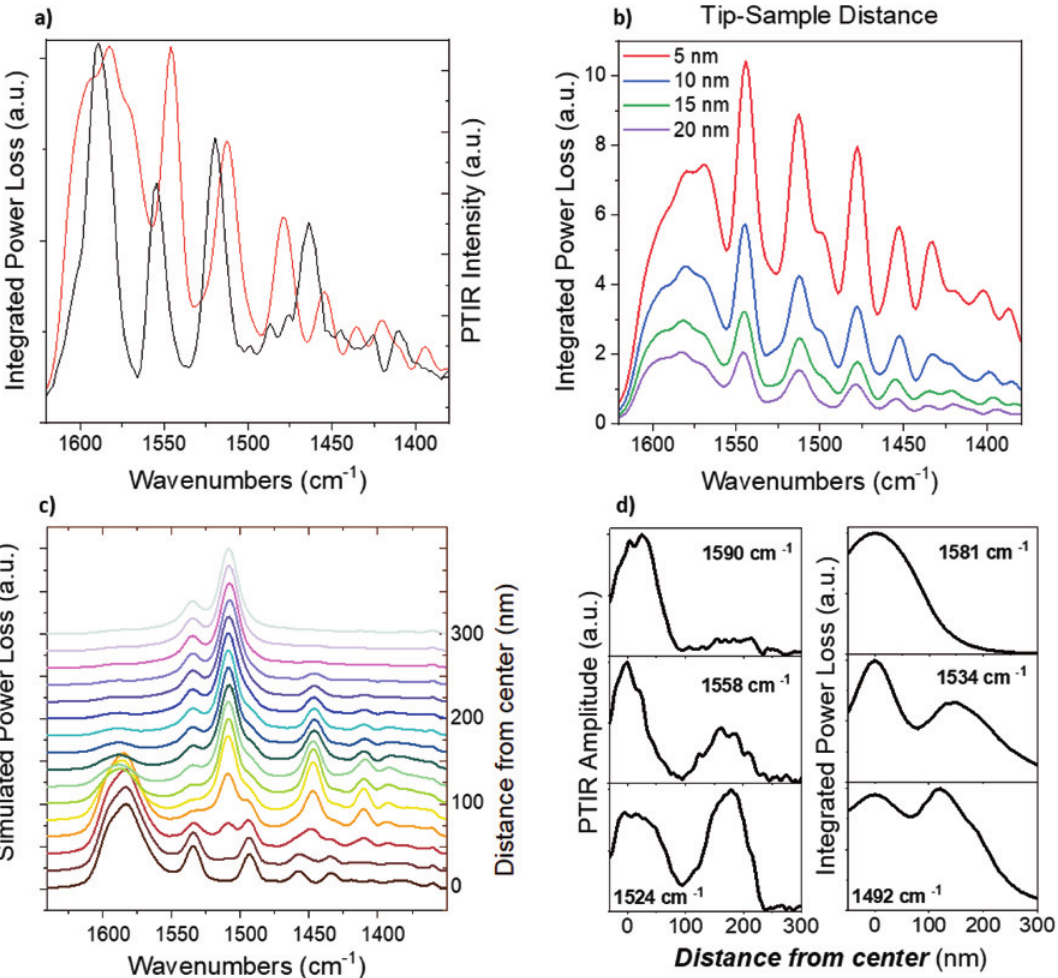
Figure4: (A)ComparisonoftheexperimentalPTIRspectrum(black)andsimulatedpowerlossspectrum(red)obtainedbypositioningtheAFMtip in the center of an isolated frustum of Ar ≈ 1.16. (B) Simulated PTIR spectra in the center of an Ar ≈ 1.16 frustum as a function of tip-sample distance. (C) FDTD integrated power loss spectra as a function of tip radial location (corresponding to Figure 3K). Spectra are shown from the center of the frustum (bottom) to 300 nm away from the center, in 20 nm increments. (D) Comparison of line cuts from PTIR scans of an Ar ≈ 1.6 frustum (Figure 3J) on the left, to the corresponding line cuts from FDTD simulations on the right, demonstrating agreement in spatial mode pro fi le. Frequenciesof linecutsarechosen for the peak centerpositionsinthe centerexperimentaland simulatedspectra identi fi